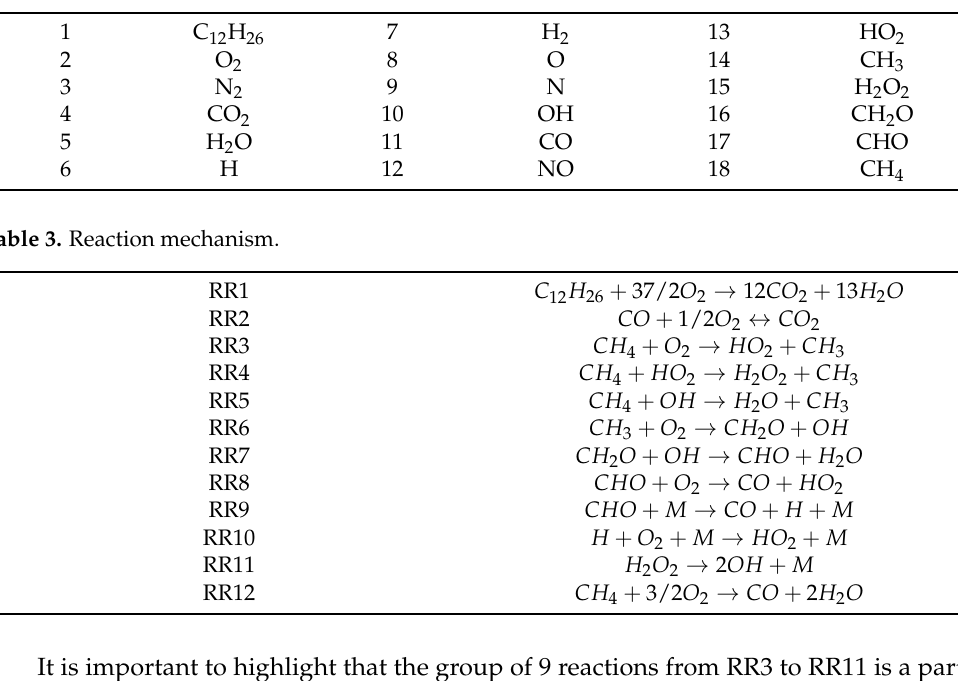
Table 2. Detailed species present in the mechanism.